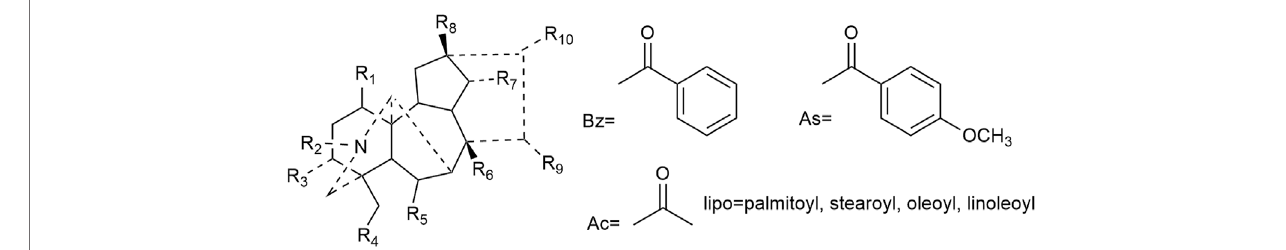
FIGURE 2 | Structures of C 19 diterpenoid alkaloids in Fuzi.